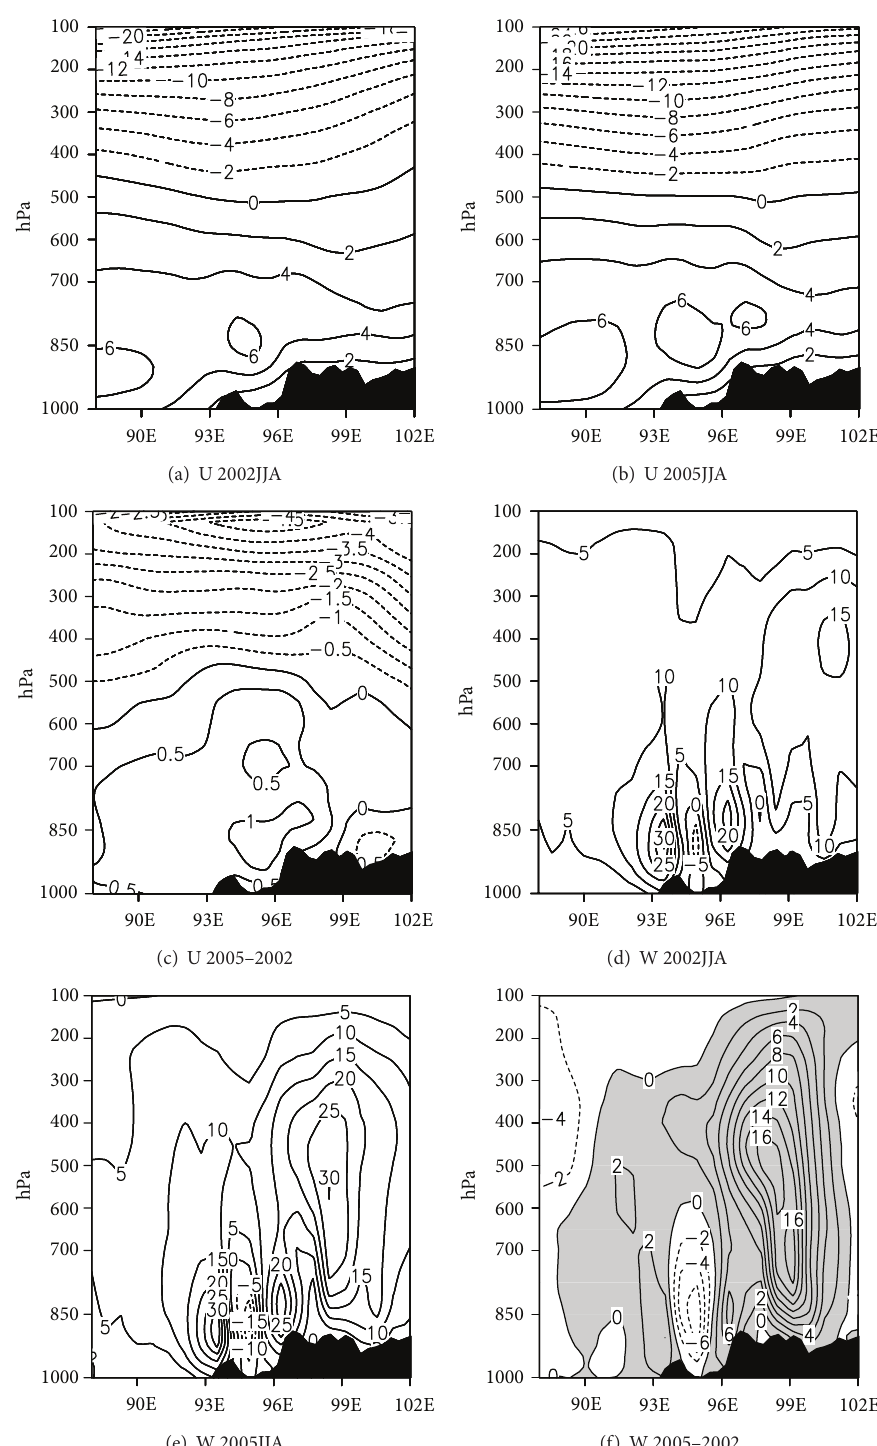
Figure 6: JJA mean zonal wind (ms −1 ) and vertical motion ( − 1.0 × 10 −2 Pa s −1 ) from the ECMWF ERA-Interim data at 0.75 ∘ resolution in 2002 ((a), (d)), 2005 ((b), (e)), and their difference ((c), (f)) averaged within latitudinal band of 19–21 ∘